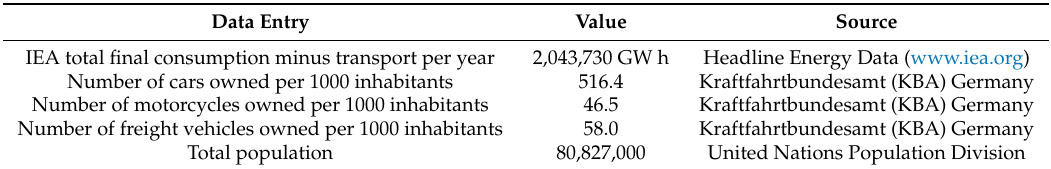
Table 6. Values added to the large scale urban consumption of energy (LUCY) database for Germany for the year 2010.